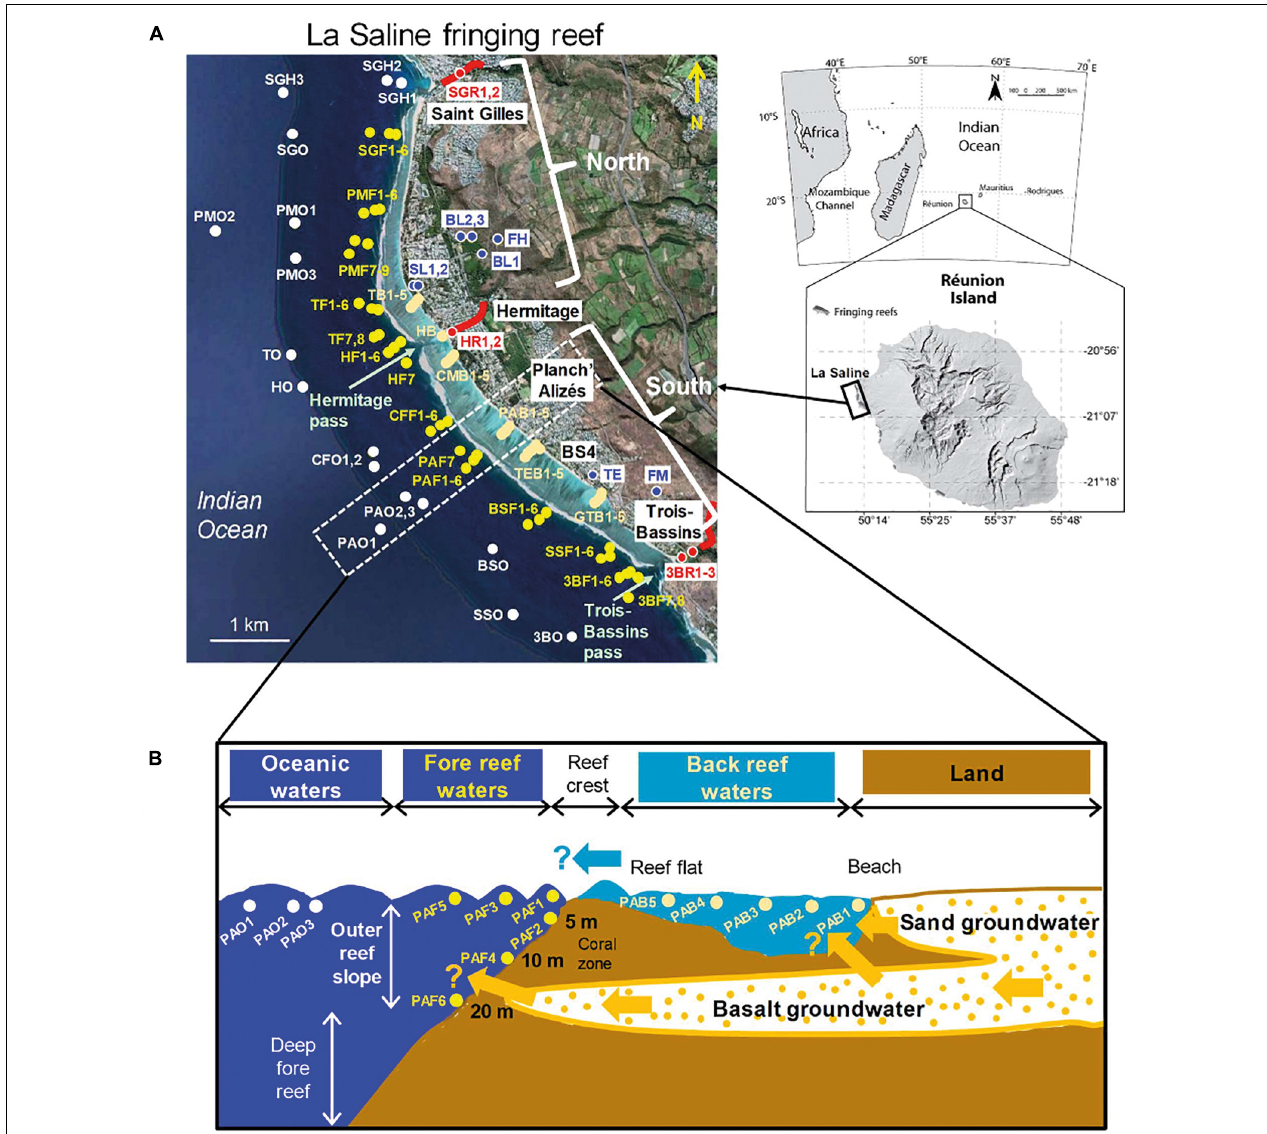
FIGURE 1 | (A) Location of the study stations in La Saline fringing reef system (La Réunion Island, southwestern Indian Ocean), including rivers, groundwater (freshwaters), back reef waters, fore reef waters, and oceanic waters. “North” includes fore reef sites located north of the Hermitage river (i.e., SGF, PMF, TF, HF), while “South” gathers fore reef sites positioned south of the Hermitage river (i.e., CFF, PAF, BSF, SSF, 3BF). Station map made from Google Earth Pro V 7.3.0.3832 (August 18, 2017). The detailed characteristics of these stations are provided in Supplementary Table S1 . (B) Cross (conceptual) section of one transect (example for Planch’Alizés transect, PA) showing the different water bodies sampled from back reef to oceanic waters, and the potential discharges of sand groundwater into back reef waters, basalt groundwater into back reef and fore reef waters, as well as the water transfer from back reef to fore reef.